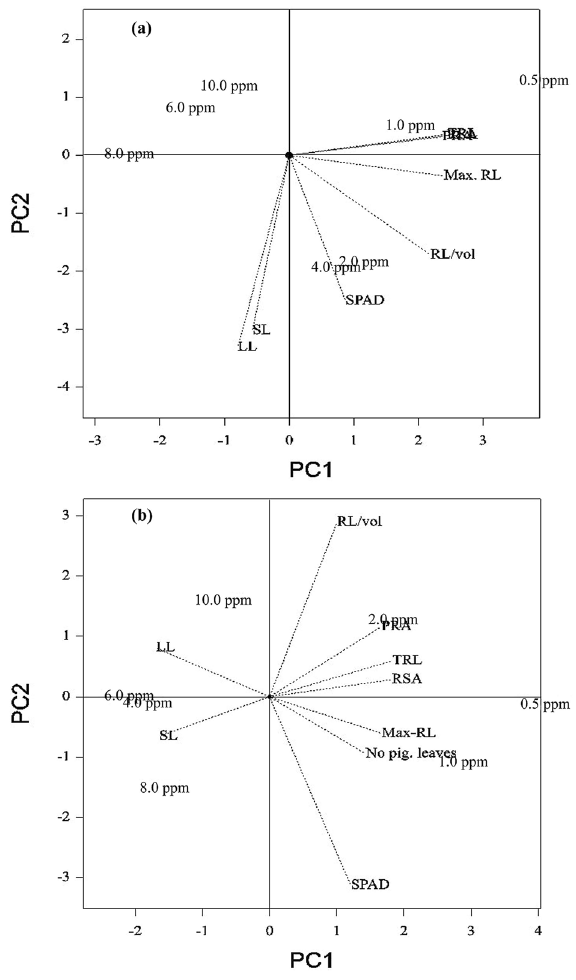
Figure 1. Concentration-by-trait biplot based on the variance exhibited by selected traits under different concentrations of phosphorus explained by two principal component axes: ( a ) 14 days after sowing and ( b ) 28 days after